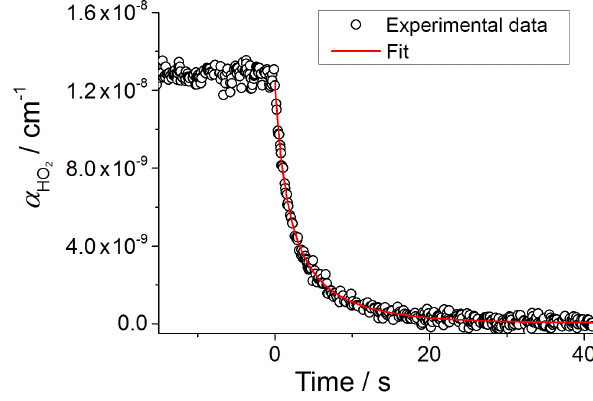
Figure 5. Second-order decay of the HO 2 absorption co- efficient at 1506.43nm obtained by CRDS. Experiments performed in HIRAC at 295K and 150mbar mixture of N 2 : O 2 = 4 : 1; [Cl 2 ] 0 ∼ 1.5 × 10 14 moleculecm − 3 and [CH 3 OH] 0 ∼ 1.0 × 10 14 moleculecm − 3 . At time zero the pho- tolysis lamps were turned off. Fitting Eq. (10) to the data gave = (1.02 ± 0.05) × 10 − 19 cm 2 molecule − 1 (statistical error at σ HO 2 1 σ